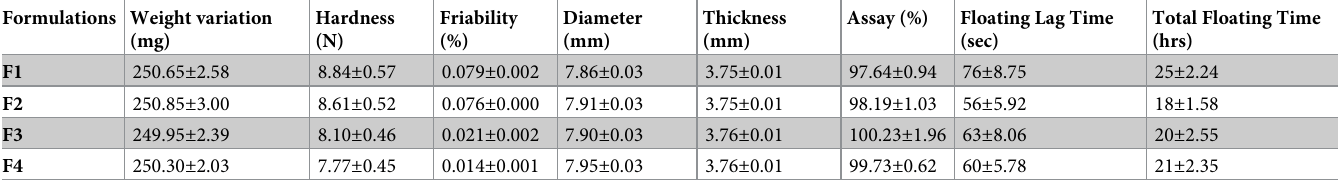
Table 4. Physicochemical characteristic of propranolol HCl floating